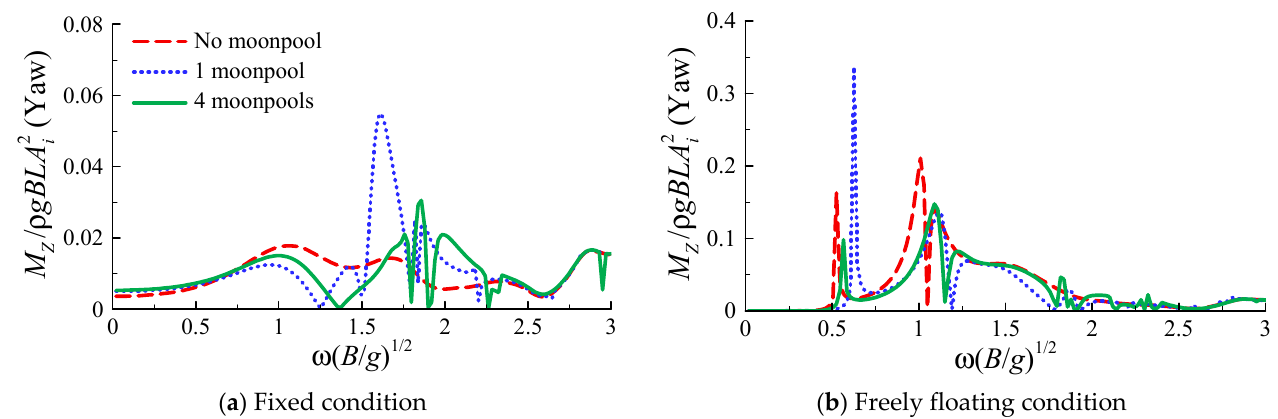
Figure 14. Calculated mean yaw drift moments on a barge with/without moonpool(s) in quartering waves ( β = 45°).